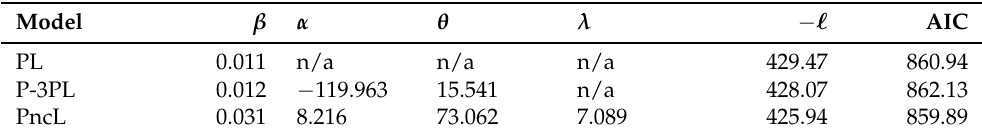
Table 6. Estimated parameters and goodness of fit statistics of considered discrete models for the guinea pigs dataset.